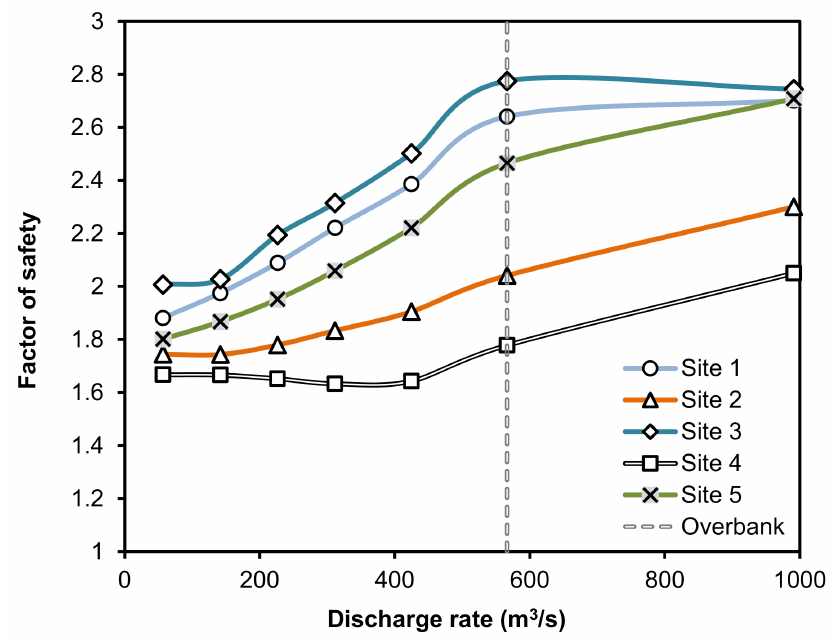
Figure 10. Relationship between discharge rate and factor of safety.